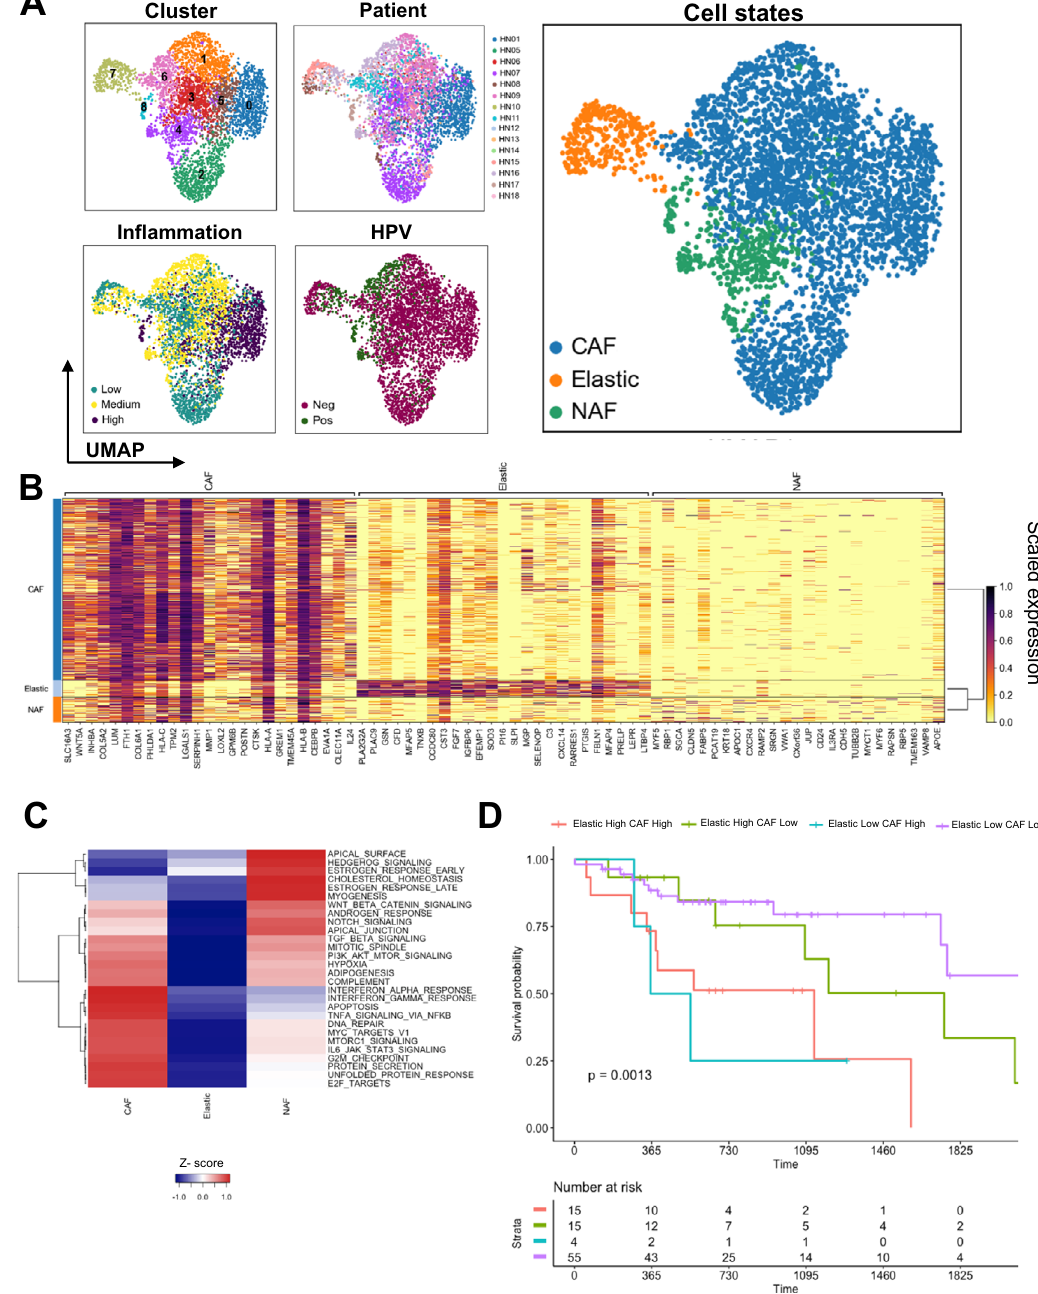
Fig. 5 Fibroblast sub-states, DEG, and impact on survival. A Sub-clustering of 4034 fi broblasts ( n = 15 patients; cluster 0 – 7) and visualization of relevant sample characteristics: patient contribution (HN01, HN05 – HN18), HPV status (HPV + vs. HPV – ), in fl ammation score (low, medium, high), and sub-states (cancer-associated fi broblasts, normal activated fi broblasts, and fi broblasts with elastic differentiation). B Heatmap showing top 25 genes characterizing each cluster (color scale depicts scaled gene expression). C Enriched hallmark gene sets between clusters based on results of gene set enrichment analysis ( “ singleseqgset ” package). D Overall survival analysis of HPV + patients from the TCGA HNSCC bulk RNAseq cohort based on gene signature scores of fi broblasts with elastic differentiation and cancer-associated fi broblasts (log rank test p =